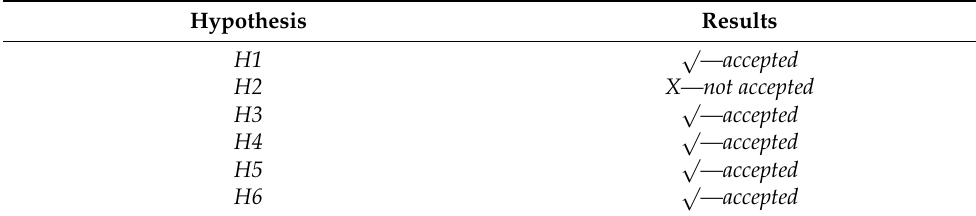
Table 5. Hypothesis results for the